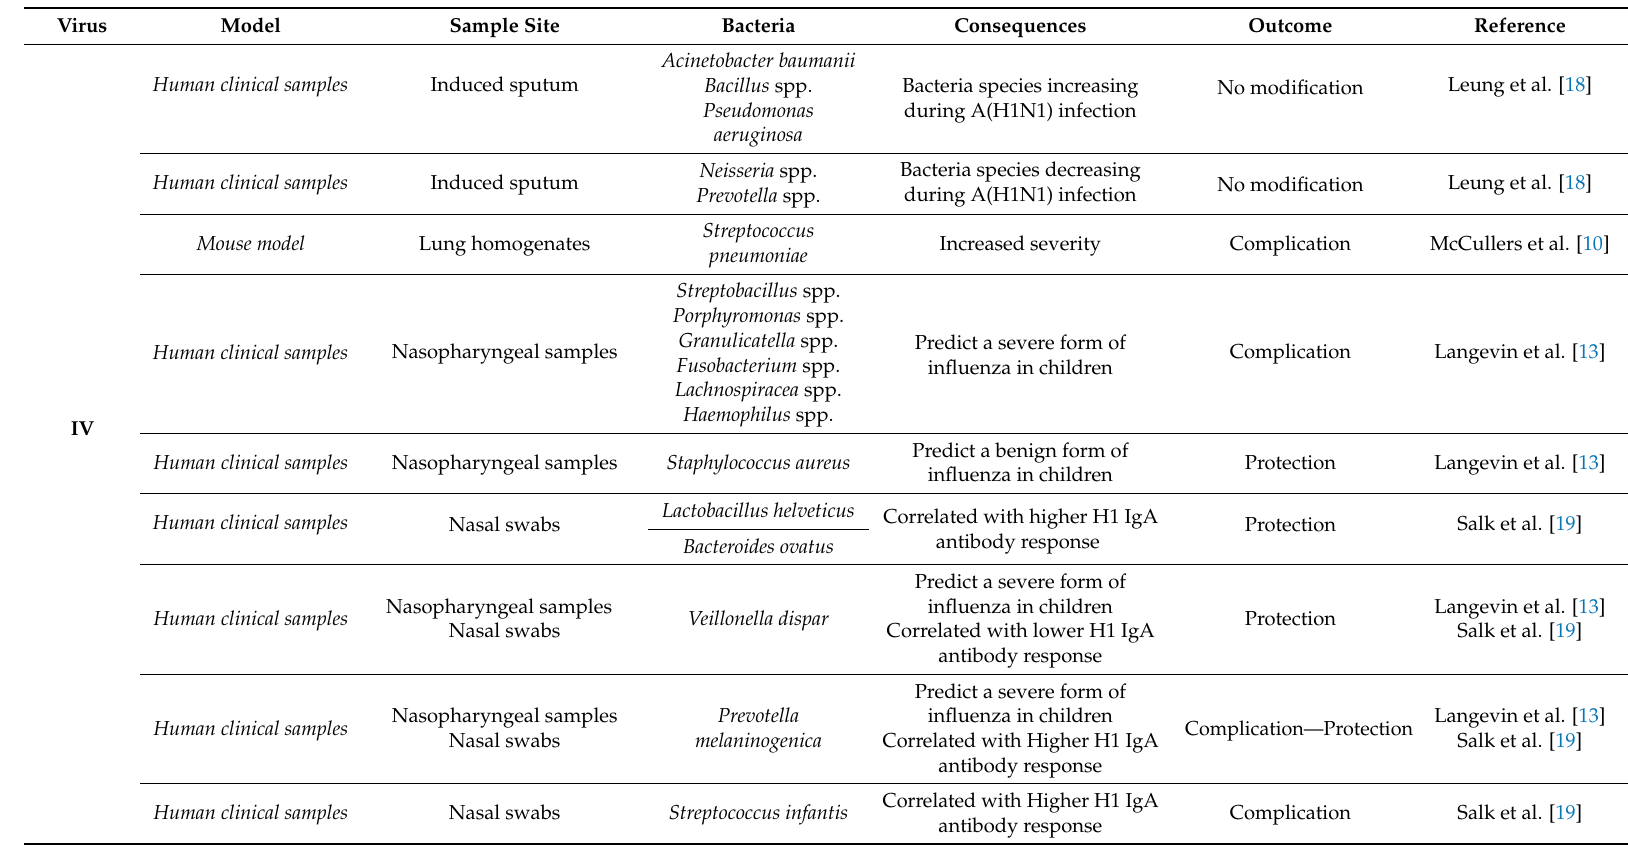
Table 1. Microbiome-specific bacteria implicated in or modified during viral infections. IV: Influenza virus; MPV: Metapneumovirus; RV: Rhinovirus; RSV: Respiratory Syncytial Virus. The main viruses responsible for respiratory infections (IV, RSV and RV) are also the most studied. It is interesting to note that the increase in considered bacteria exists independently of the observed virus ( Lactobacillus rhamnosus , Escherichia coli and Staphylococcus aureus are protective whatever the viral model; the presence of Streptococcus pneumoniae is associated with an increase of the complication rate or seroconversion). Outcome “complication”: disease worsening; outcome “Protection”: indicate a limitation of the disease